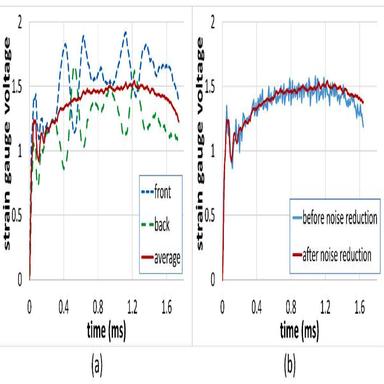
Load data (a) average of voltage signals from the strain gauges (b) noise reduction.